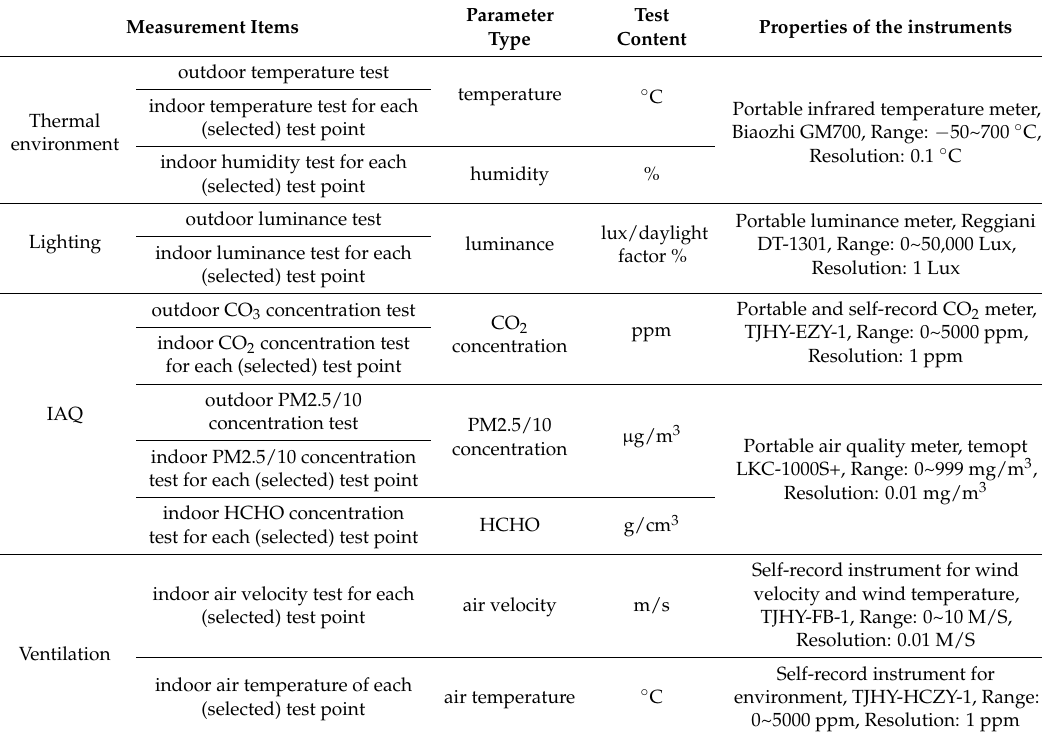
Table 2. Building the physical environment fieldwork test